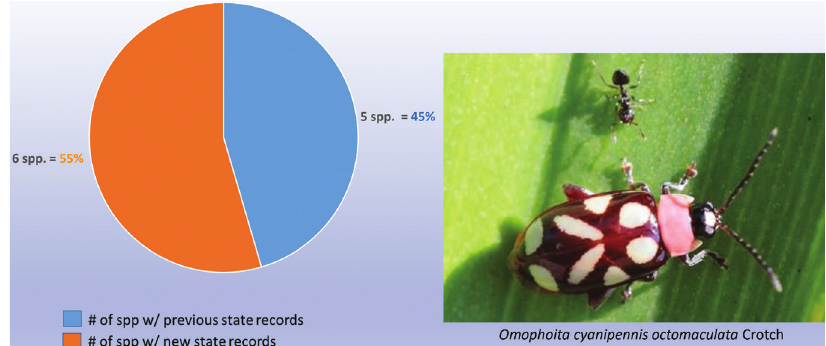
Figure 6. Omophoita Chevrolat new state records versus previously recorded state